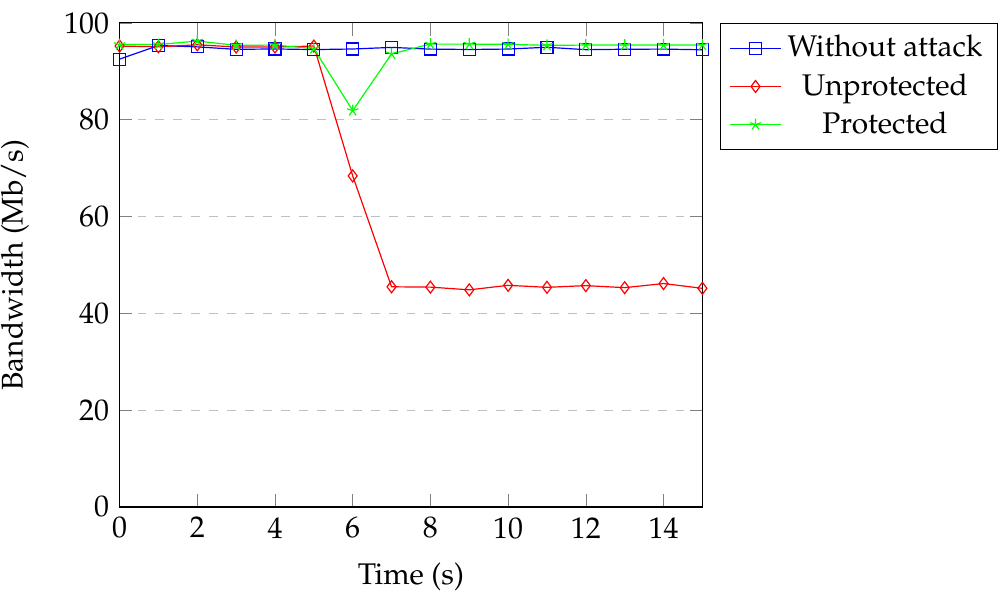
Figure 18. Available bandwidth under SYN flood with spoofing.